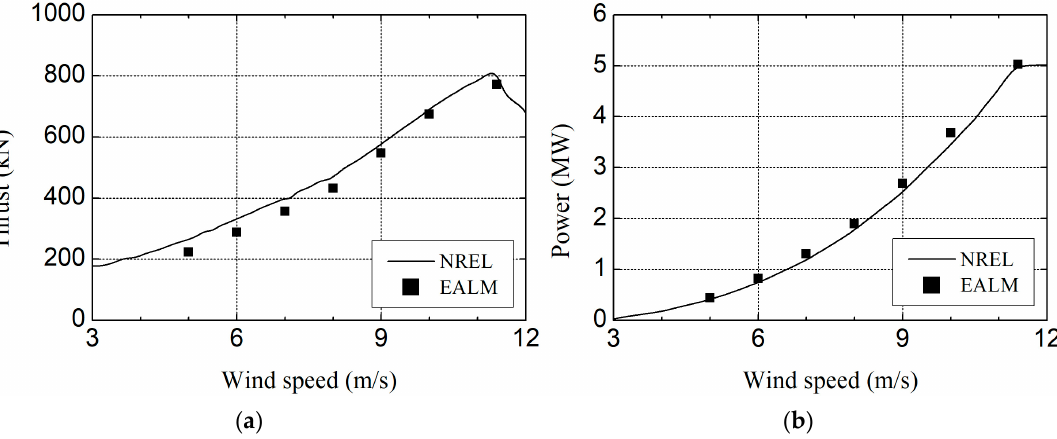
Figure 11. Comparisons of the aerodynamic performance results between elastic actuator line model